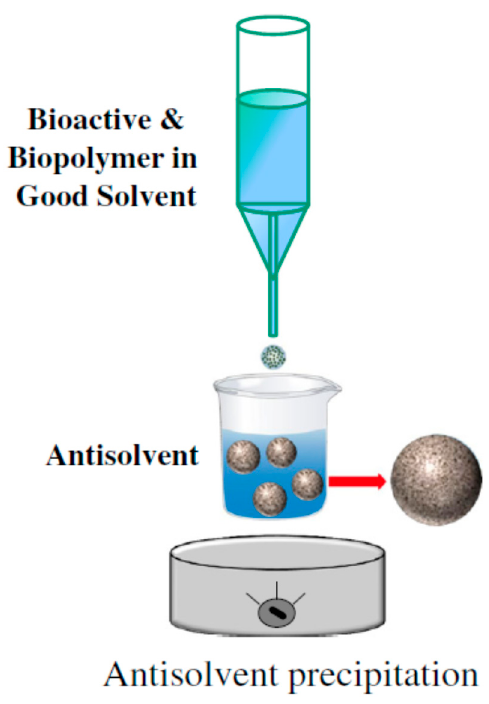
Figure 3. Antisolvent precipitation method for production of biopolymer particles (adapted from McClements 2015 [66]).